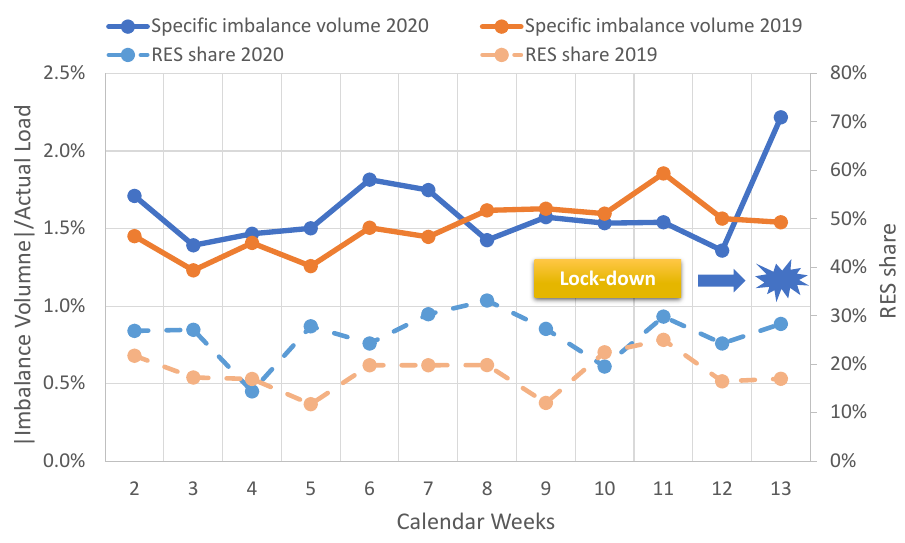
Figure 12. The weekly average share of imbalance volume factorised by the actual total load for 2019 and 2020. There is a significant imbalance increase during lockdown